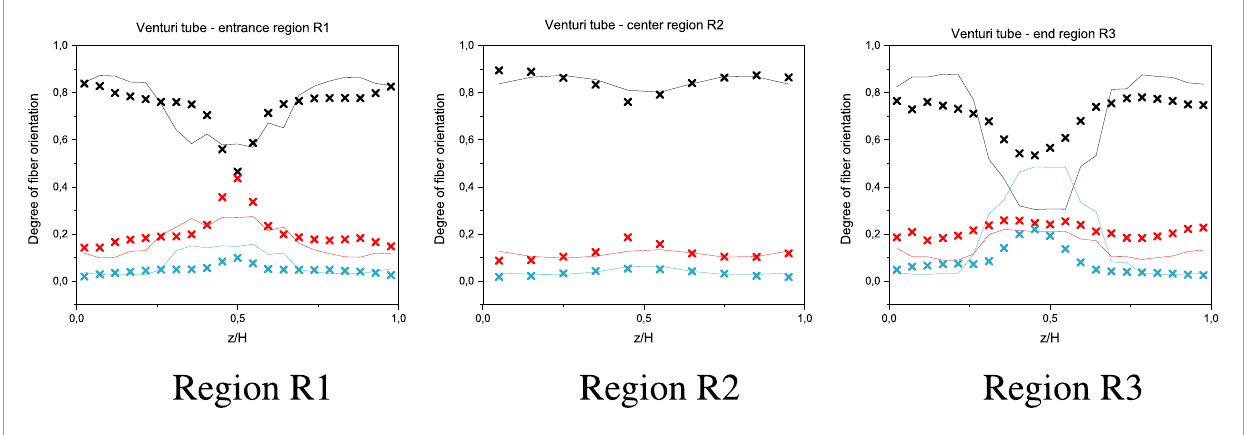
FIGURE 8 Fiber orientation distributions using the IISO-model with 5 parameters optimized for R2 (center) X : CT measurements, lines: simulation results, fiber orientation directions: black: xx (in-flow), red: yy (across flow), teal: zz (through-thickness).